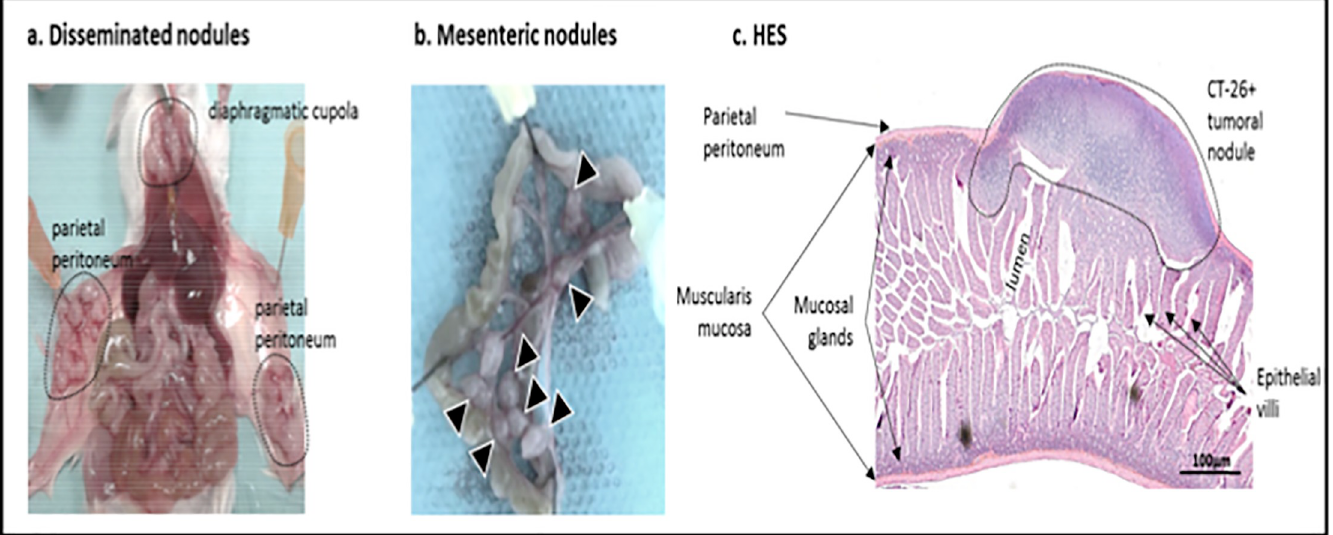
Fig 2. Images after mouse laparotomy at day 15 post-grafting, (A) A group showed extensive intraperitoneal tumor growth localized majority on the parietal peritoneum and the diaphragm, and (B) IP group displayed a limited peritoneal metastasis localized on the visceral peritoneum. (C) HES staining in the intestinal bowel with peritoneal tumoral